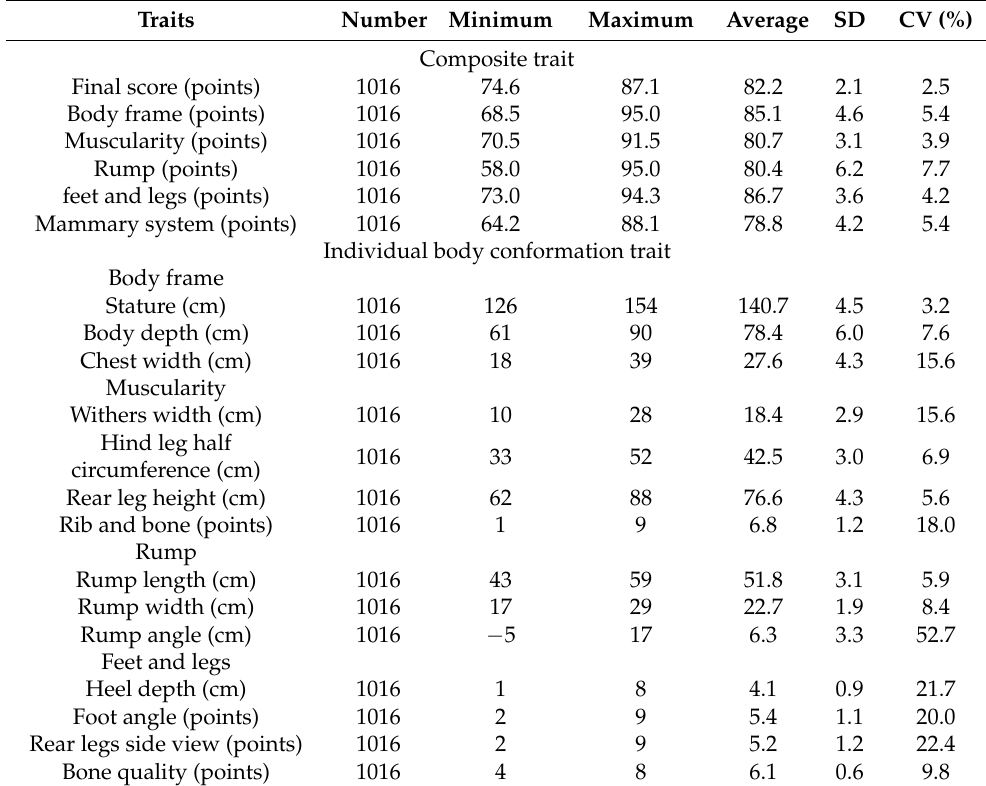
Table 1. Description of body conformation traits in dual-purpose Simmental